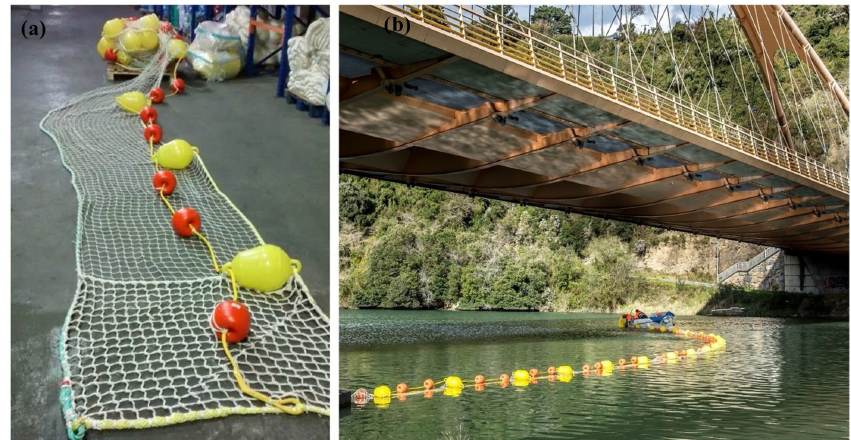
Figure A1. Floating barrier (a) and installation in the Deba River (Gipuzkoa) (b) .